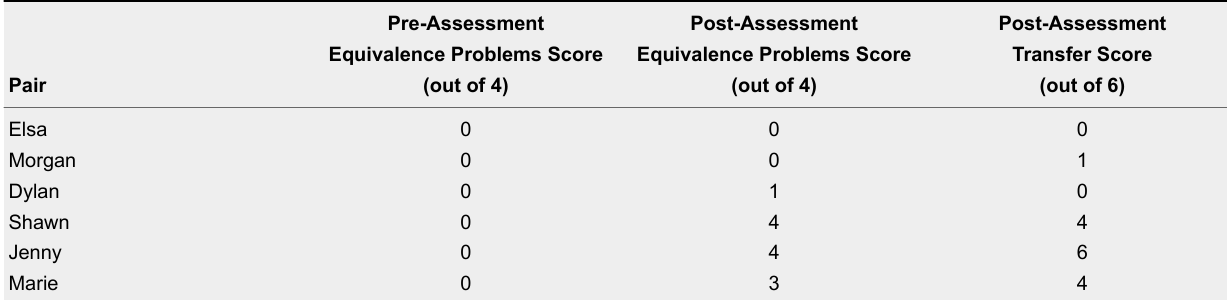
Focal Data (Six Participants) With Pre-Assessment, Post-Assessment, and Transfer